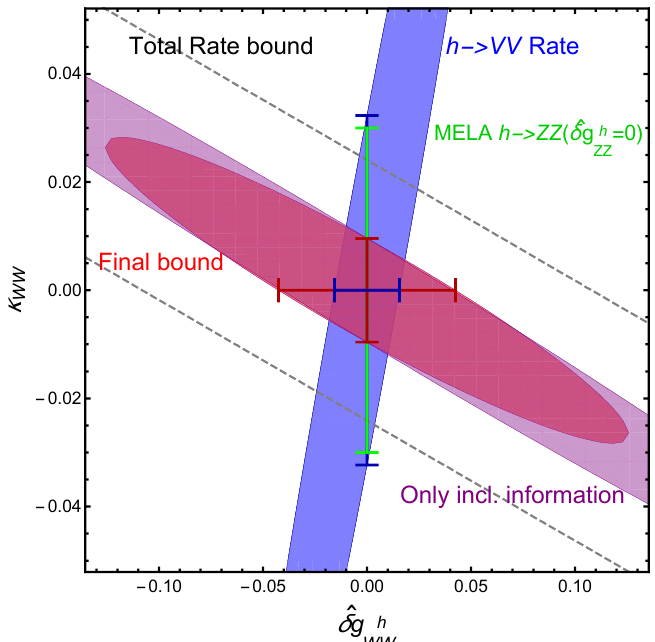
Figure 5 . Bounds at 65% CL on the CP -even anomalous couplings, with 3 ab (cid:0) 1 integrated luminosity, after combining results from Zh and Wh production using eq. (2.7) and assuming that the contact terms have been very precisely constrained (see eq. (6.2)). Again, we show the progression of the bounds as more and more di(cid:11)erential information is included in the (cid:12)t. The dashed lines show the bound just from the total rate in both processes. The purple region includes di(cid:11)erential information at the level of the Z=W -boson four momentum. The red region is our (cid:12)nal bound and includes information from all the angular moments. The blue band shows the bound from a combination of h ! WW ! 2 l 2 (cid:23) and h ! ZZ ! 4 ‘ rate using the results of ref. [105]. The bars show the bounds on one of the couplings when the other coupling is zero. The green bar shows the bound implied by the bound on (cid:20) ZZ using the Matrix Element Likelihood Analysis (MELA) in ref. [79] and assuming (cid:14) ^ g h = ZZ